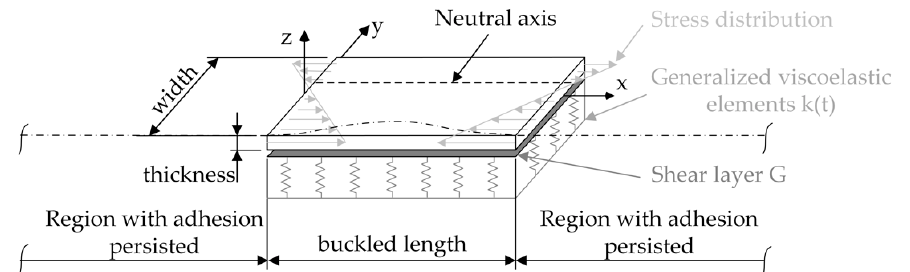
Figure 9. Schematic illustration of an anisotropic plate on elastic foundation illustrating an approach by Béakou et al. [54] and Hörmann [51] to describe out-of-plane tape buckling for a steered tape automated fiber placement, modified from during automated fiber placement, modified from [51,54,55]. Table 1. Variation of minimum steering radius with slit-tape width for a 102 mm track width [50].